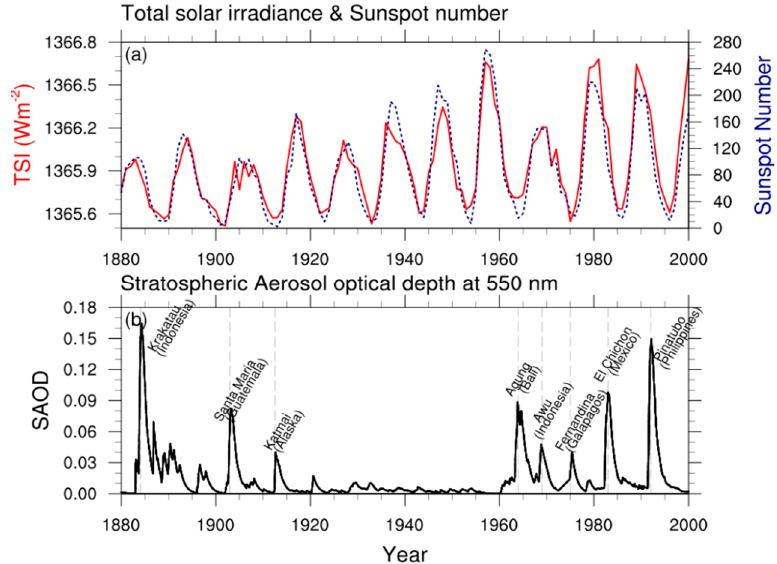
Figure 3. Time variation of ( a ) total solar irradiance (TSI; red solid line) for CMIP5 & observed sunspot number (blue dotted line), ( b ) stratospheric aerosol optical depth at 550 nm (SAOD) from 1880 to 2000. Annual mean TSI time series provided from National Oceanic and Atmospheric Administration (NOAA). Sunspot data from Solar Influences Data Analysis Center (SIDC, Royal Observatory of Belgium). Monthly mean stratospheric aerosol optical depth (SAOD) dataset used from NASA Goddard Institute for Space Studies (GISS). Dotted vertical gray lines denote the times of maximum SAOD during major volcanic eruptions.